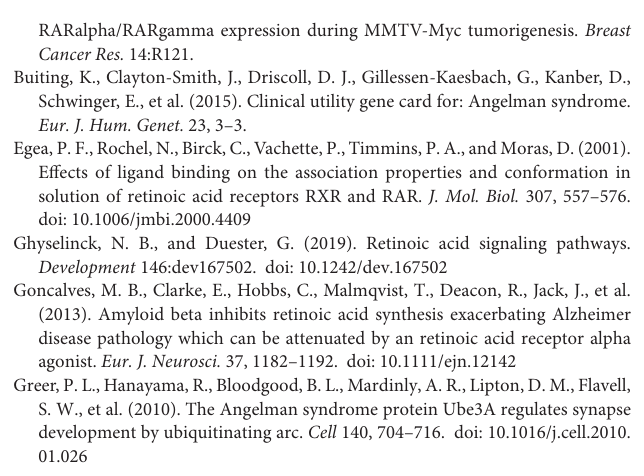
Supplementary Table 1 | The list of genes most related to UBE3A. Supplementary Table 2 | Differentiated expressed gene list in RNA-seq. Supplementary Table 3 | The list of RA-regulated genes. Supplementary Table 4 | Overlapping genes. Supplementary Table 5 | Sequences of the siRNAs for UBE3A. Supplementary Table 6 | Sequences of the primers used in